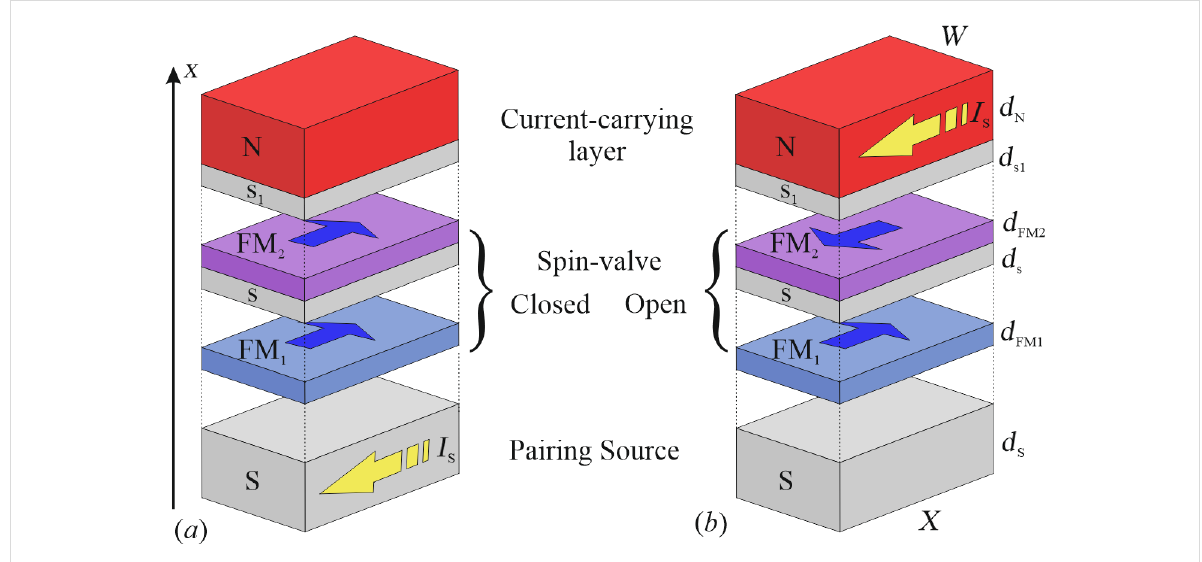
Figure 5: Sketch of the tunable kinetic inductance based on multilayer structure in the (a) closed and (b) open states. Blue solid arrows reveal magne- tization orientation of FM 1 and FM 2 layers, and dashed yellow arrows demonstrate direction and localization of the supercurrent I S